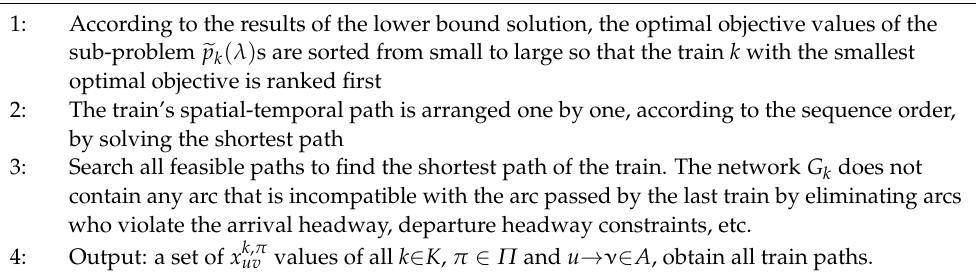
Algorithm 2 Greedy